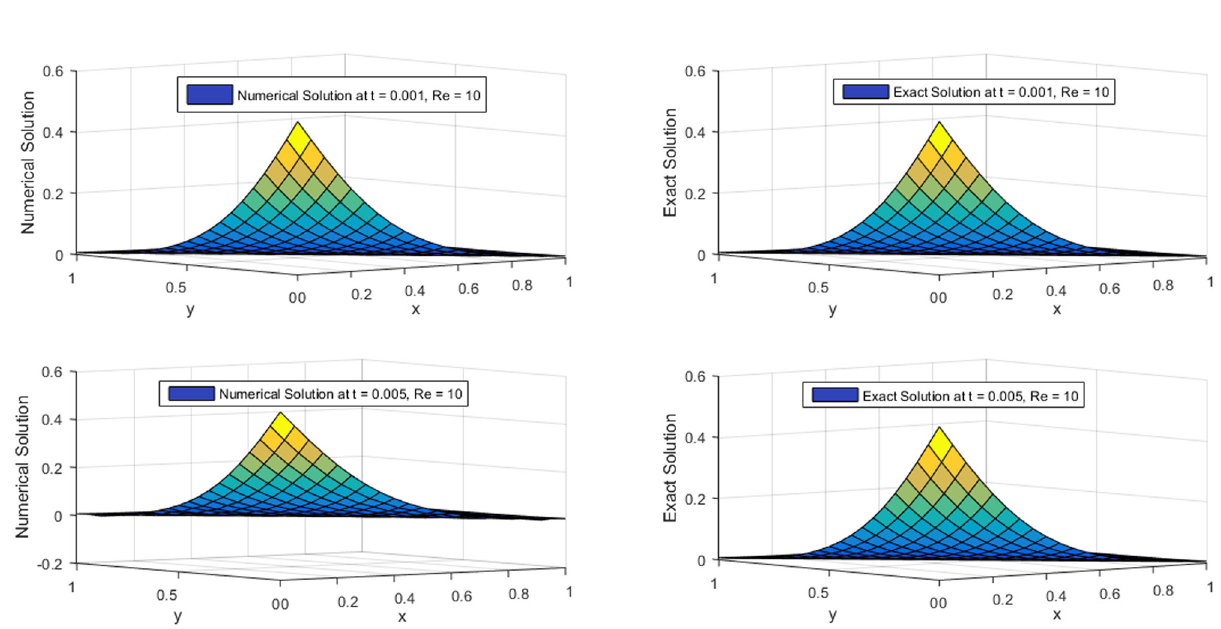
Figure 10: Graphical presentation of solutions at = t 0.001 and = t 0.005 , respectively, for = N 21 , = t Δ 0.0001 with Re =